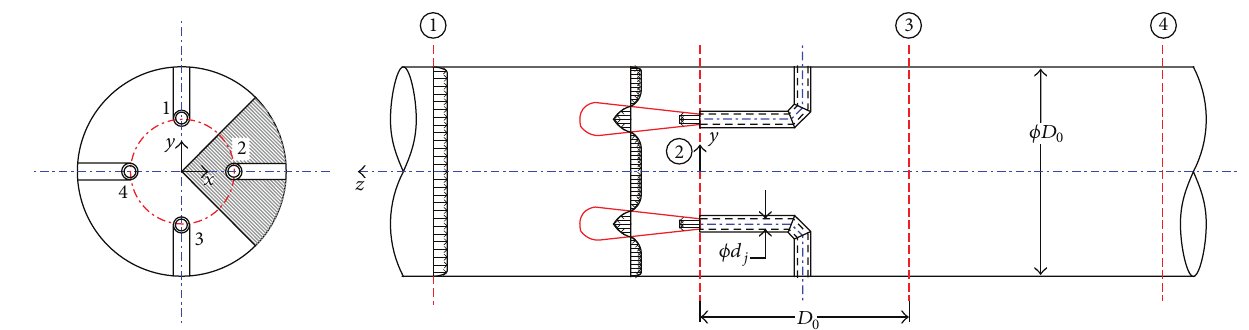
Figure 1: Schematic description of the flow field of four circumferentially arranged jets in confined counterflow.